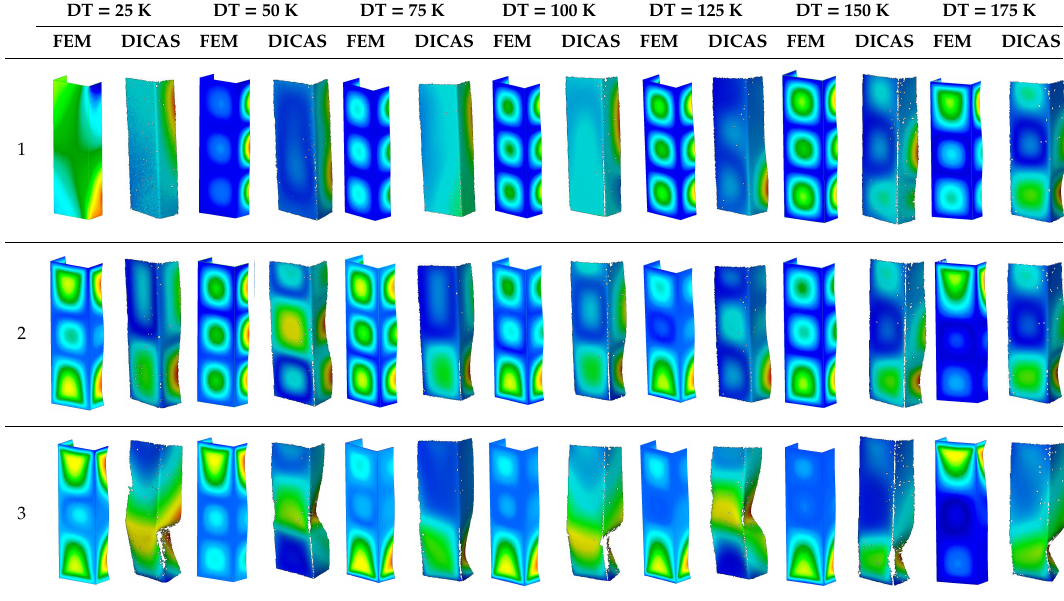
Table 4. The comparison of recorded modes in total displacements for both methods.